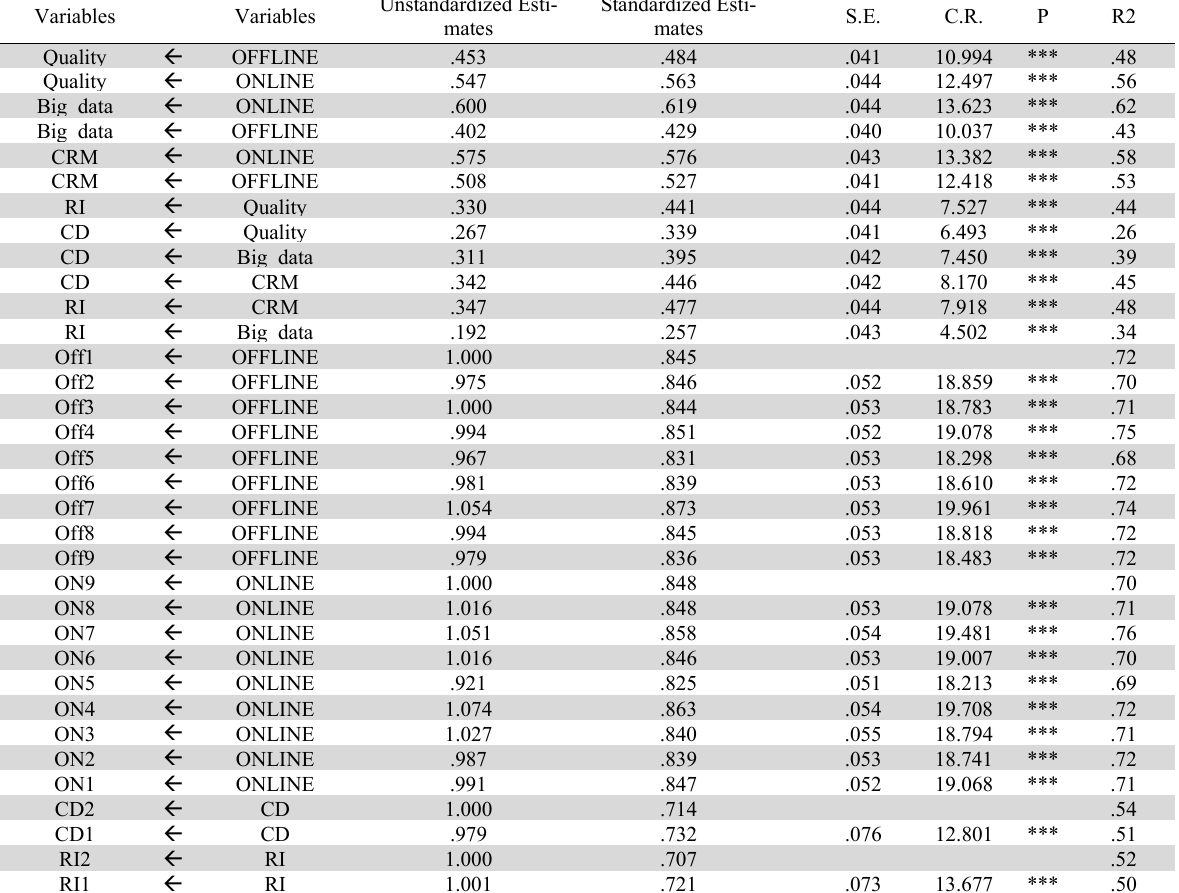
Standardized Estimate